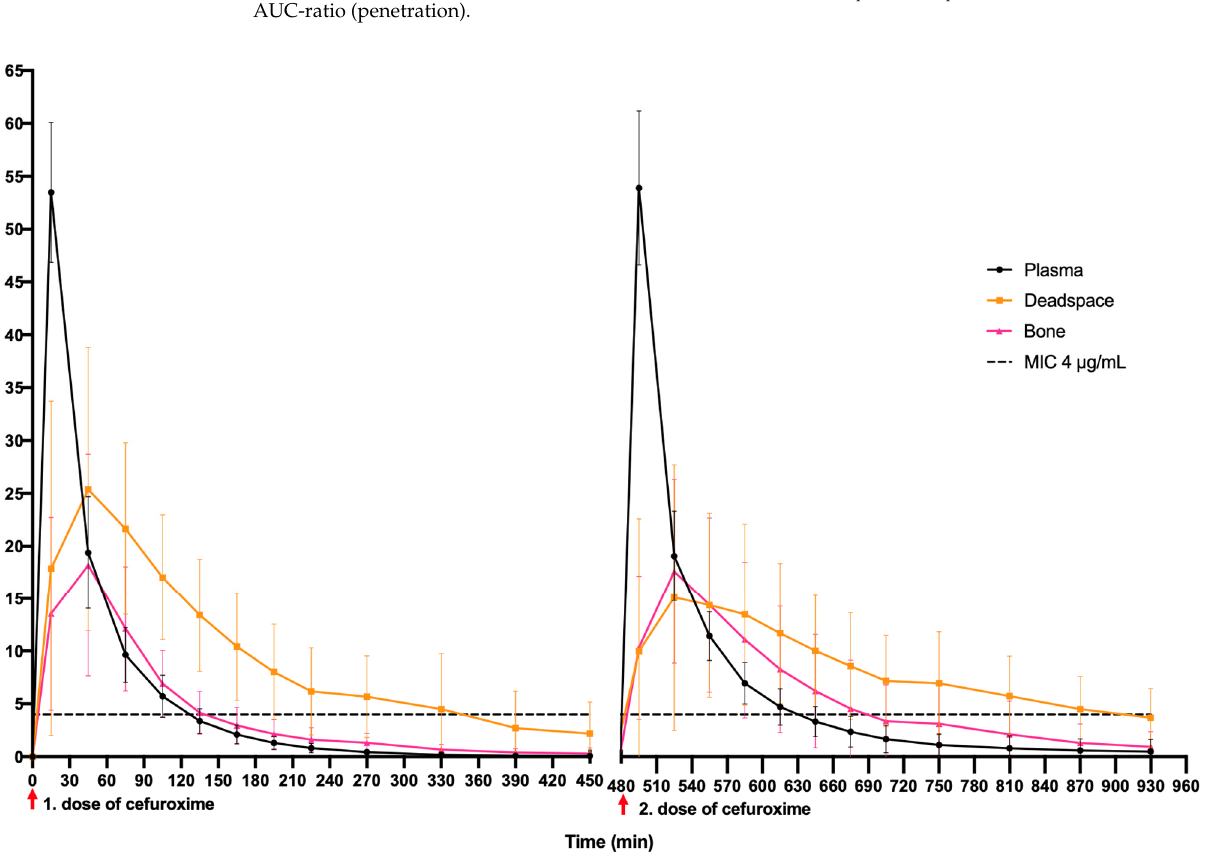
Figure 1. Mean concentration–time profiles across weight groups of cefuroxime in plasma, deadspace and bone over two dosing intervals. SD visualised with bars. Table 4. A pooled comparison across weight groups of key pharmacokinetic parameters for the two dosing intervals in plasma, deadspace and bone.